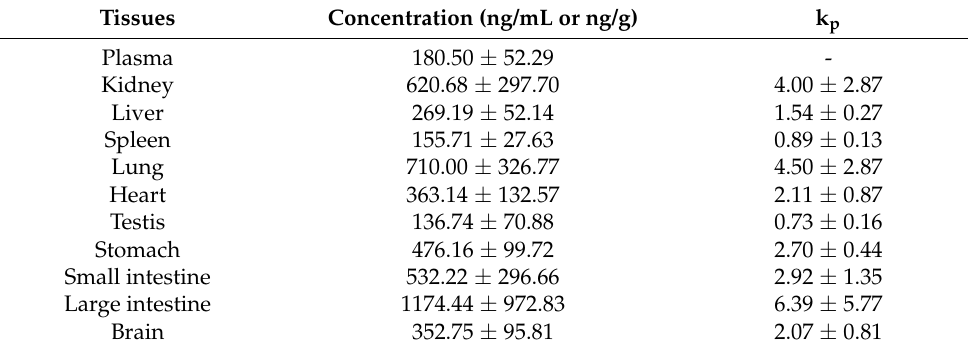
Figure 3. Average plasma concentration-time profile of BP-3 during i.v. infusion in rats (n = 4, mean ± S.D.). Table 4. Average concentration and plasma-to-tissue partition coefficients (k p ) of BP-3 in tissues determined under steady state conditions (n = 4, mean ± S.D.).